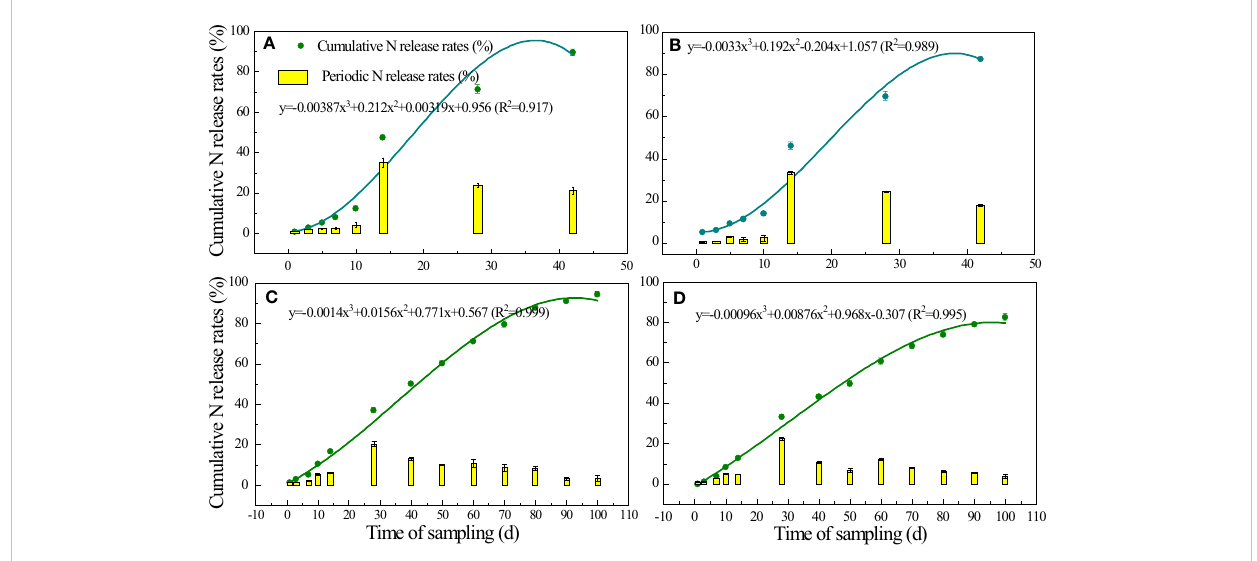
FIGURE 3 Cumulative N release rates (curves) and periodic N release rates (bars) of CRNs with periods of 40 d (A, B) and 90 d (C, D) incubated in paddy fi elds (A, C) and water (25°C) (B, D) in